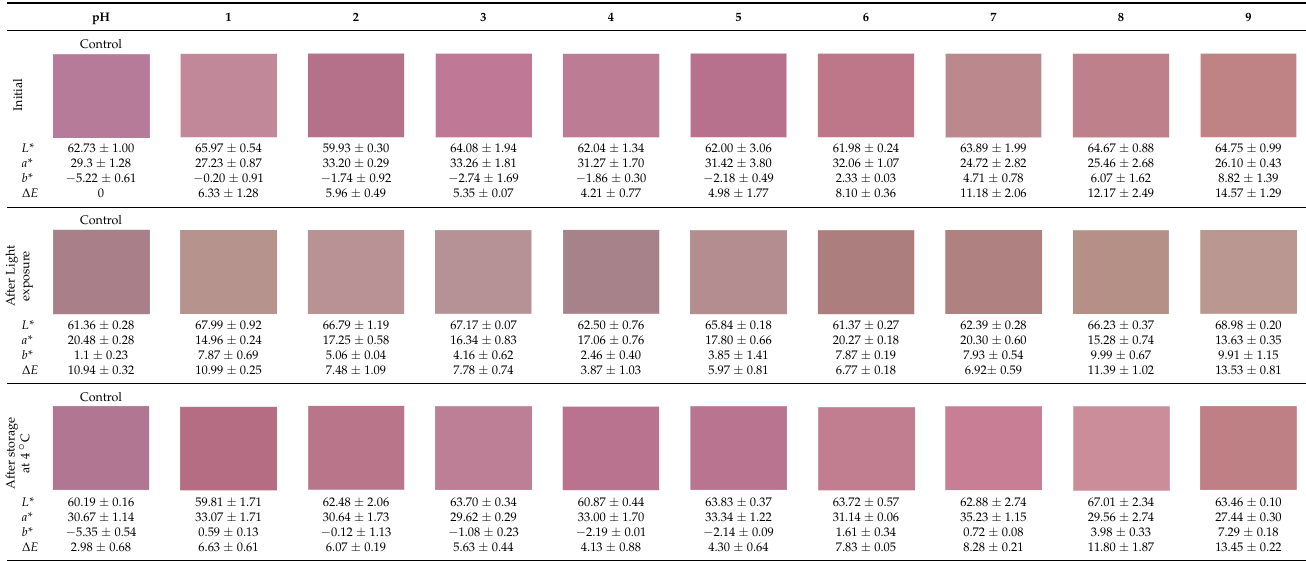
Table 6. Apparent color, colorimetric parameters, and total color difference ( ∆ E ) of the BC-prodigiosin indicator at different pH values (1 to 14), first row contains initial values, second row contains the data obtained after light exposure (120 h), and the third row consist of data after storage at 4 ◦ C (120